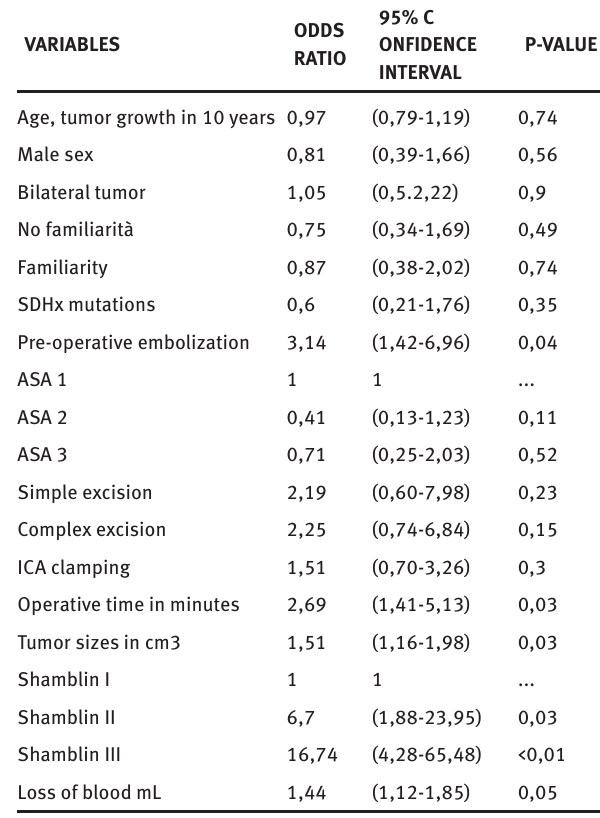
Table 4: Results of the logistic regression model for evaluation of temporary damage of cranial nerves. 2004-2016